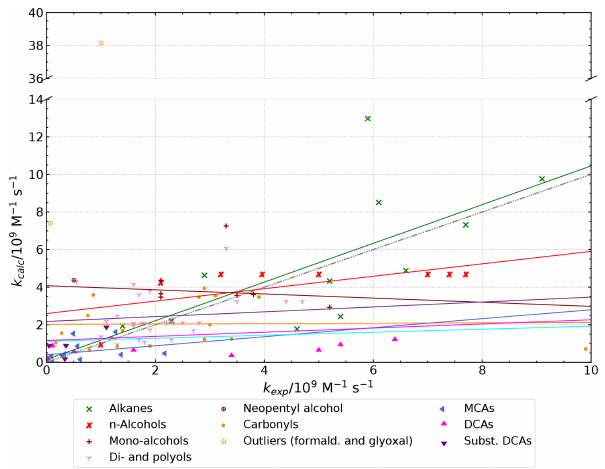
Figure 3. Plot of predicted versus experimental data for Evans– Polanyi correlations of OH radical reactions with organic com- pounds differentiated by compound class. Parameters of the regres- sion lines are given in Table S8 in the ESM. The regression lines have the same colour code as the data points. The black dashed- dotted line is the line of same